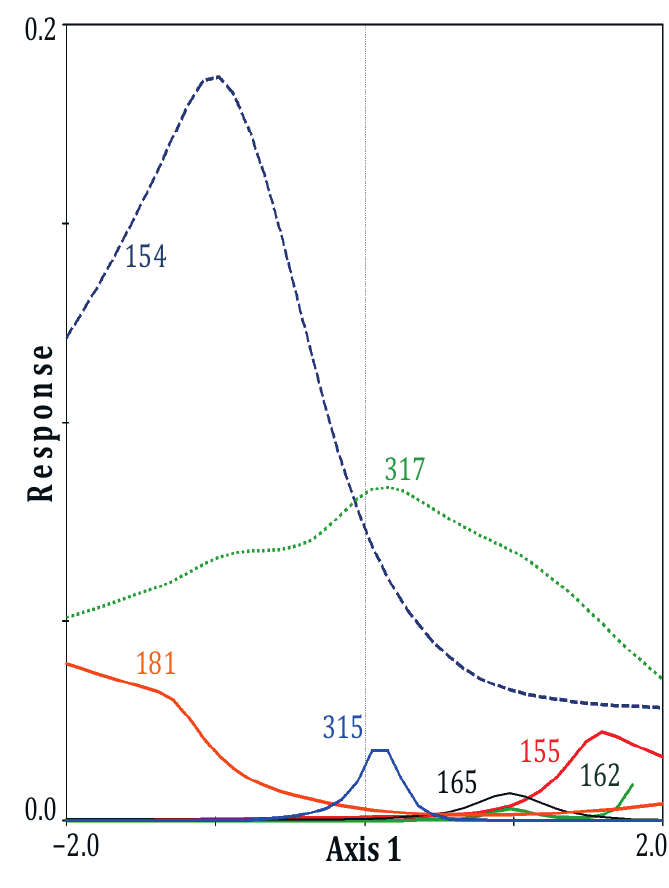
Figure 5. Response curve showing the distribution of seven TRFLP-OTUs (fractional abundance in y-axis) in response to all environmental parameters studied (as Axis 1 generated by pRDA analysis, Figure 4). All non-linear relationships are significant ( p < 0.05), except for OTU #317. Each colored curve indicates a different TRFLP-OTU. Data fitted using generalized additive models (GAM) with a Poisson distribution using log link function, df = 3. From pRDA analysis: Axis 1 Eigenvalue = 12.3%, p = 0.01, model explained 56% of OTUs